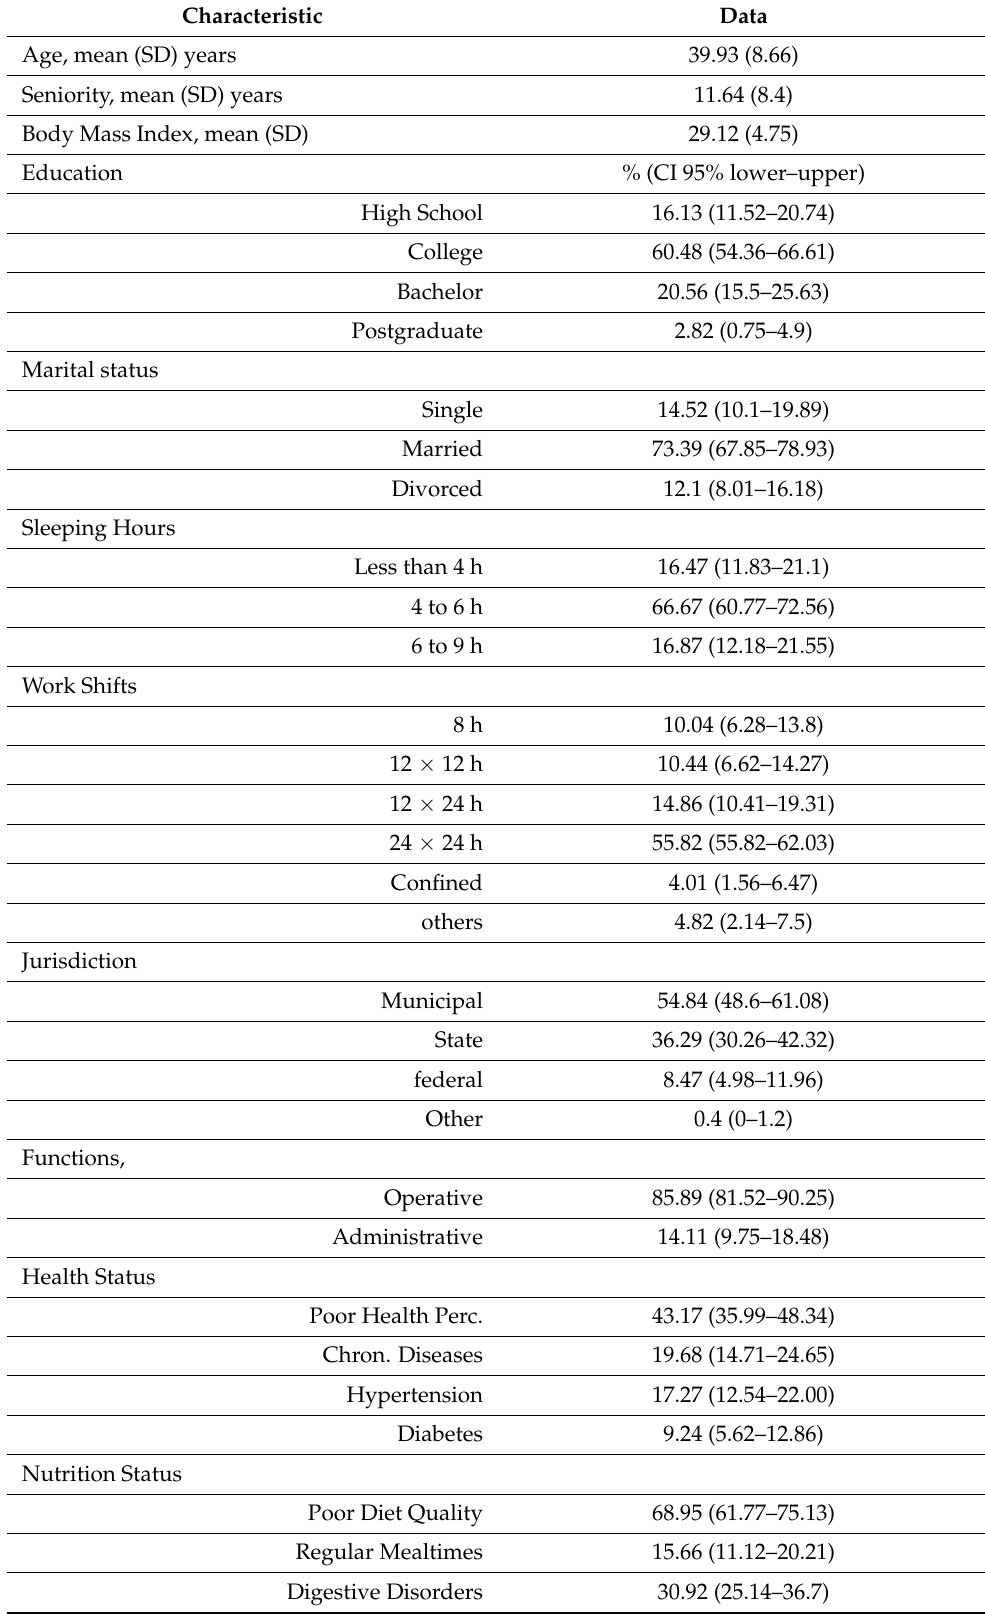
Table 2. Characteristics of the studied